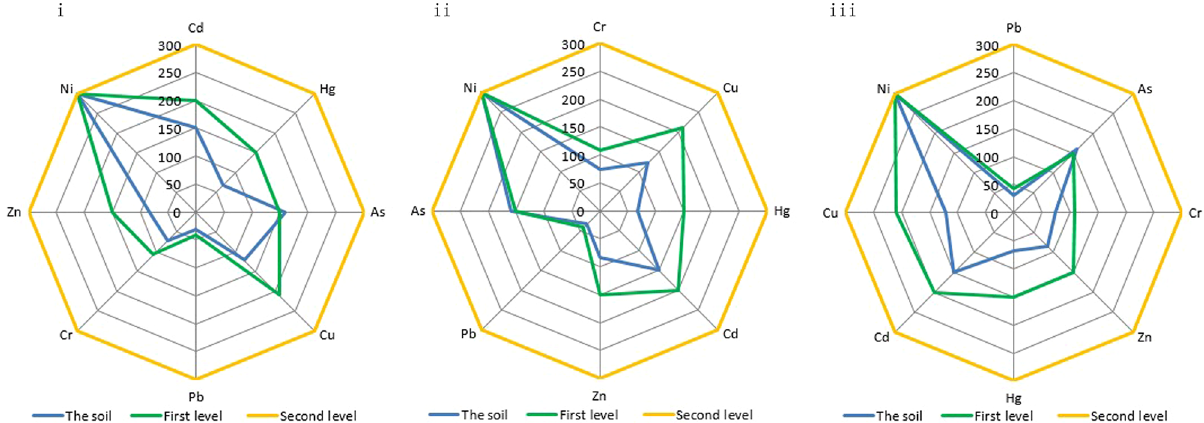
Figure 5. Environmental quality radar charts of 20–40 cm soil in the hilly area with different indicator